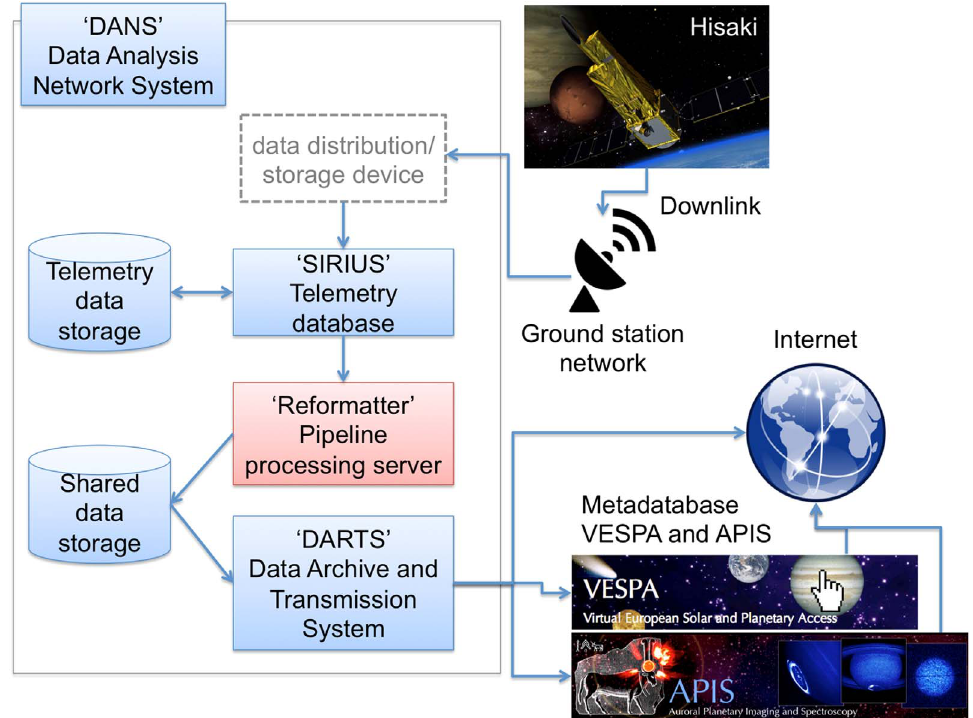
Fig. 1. Overview of Data Analysis Network System (DANS). Telemetry data downlinked from Hisaki are received at the ground station network and stored in the data distribution/storage device. The pipeline system processes the stored telemetry data transferred via the telemetry archive SIRIUS. The processed data are archived as high-level science data products in the Data Archive and Transmission System (DARTS), and high-level data products are published to the internet from DARTS. Metadata of the high-level data are archived in European metadatabases, VESPA and APIS, and are published to the